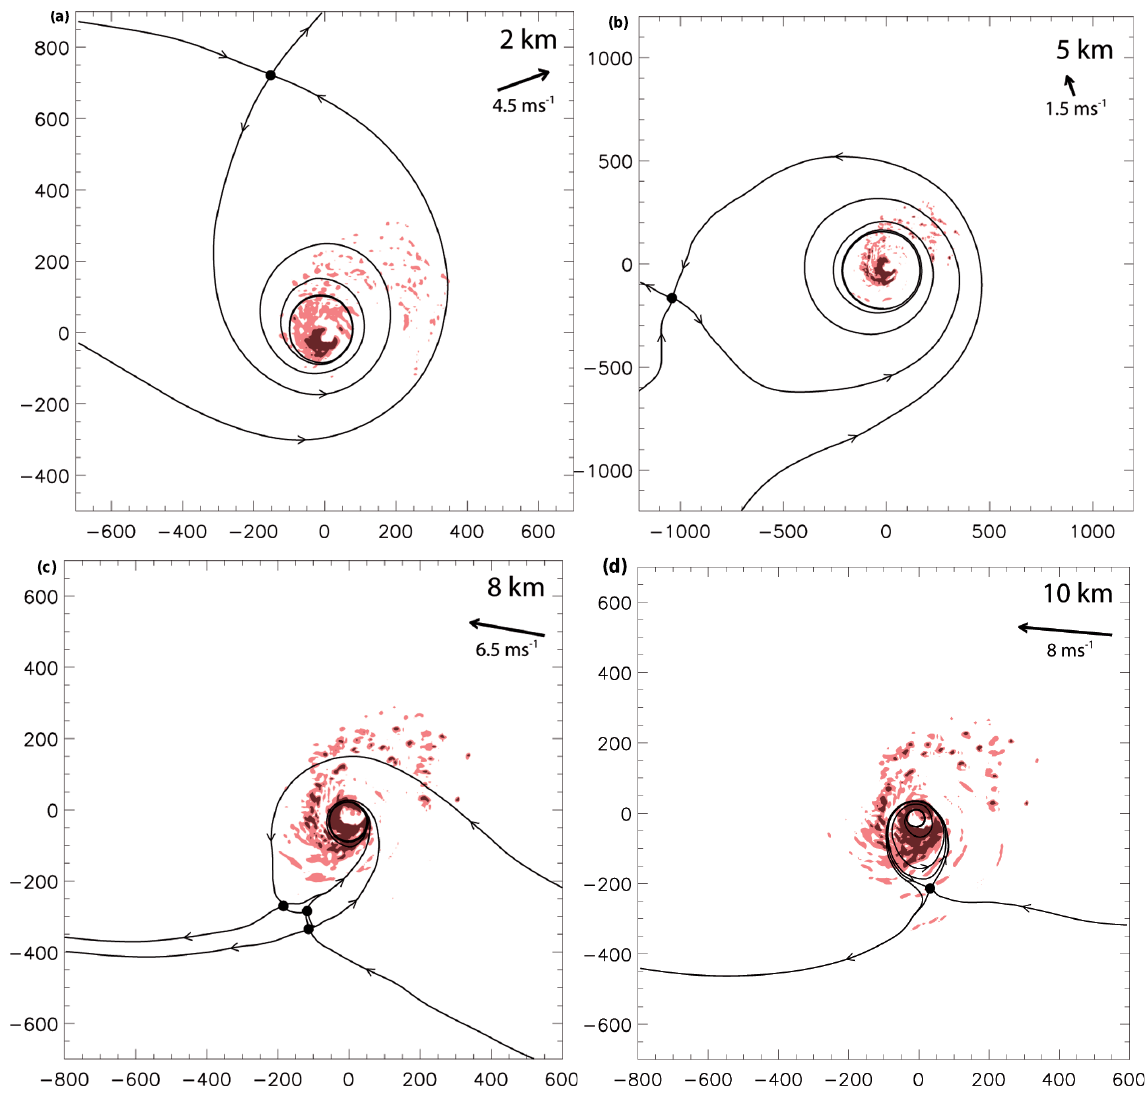
Fig. 3. Stagnation points (black dots) and manifolds at 2km (a) , 5km (b) , 8km (c) , and 10km (d) height. The eyewall updrafts are indicated by the dark red shading (1ms − 1 ), light red shading denotes vertical motion of 0.25ms − 1 . The magnitude and direction of the storm-relative flow is given in the upper-right of each panel. The values are rounded to 0.5ms − 1 . The storm-relative environmental flow is calculated as the averaged flow between 200km and 1000km radius. The storm-relative asymmetric flow in this region is essentially uniform (not shown). All fields are from the 15mps run of RMN and averaged from 3–8h. The horizontal scale is in km; note the larger scale at 5km height in (b)